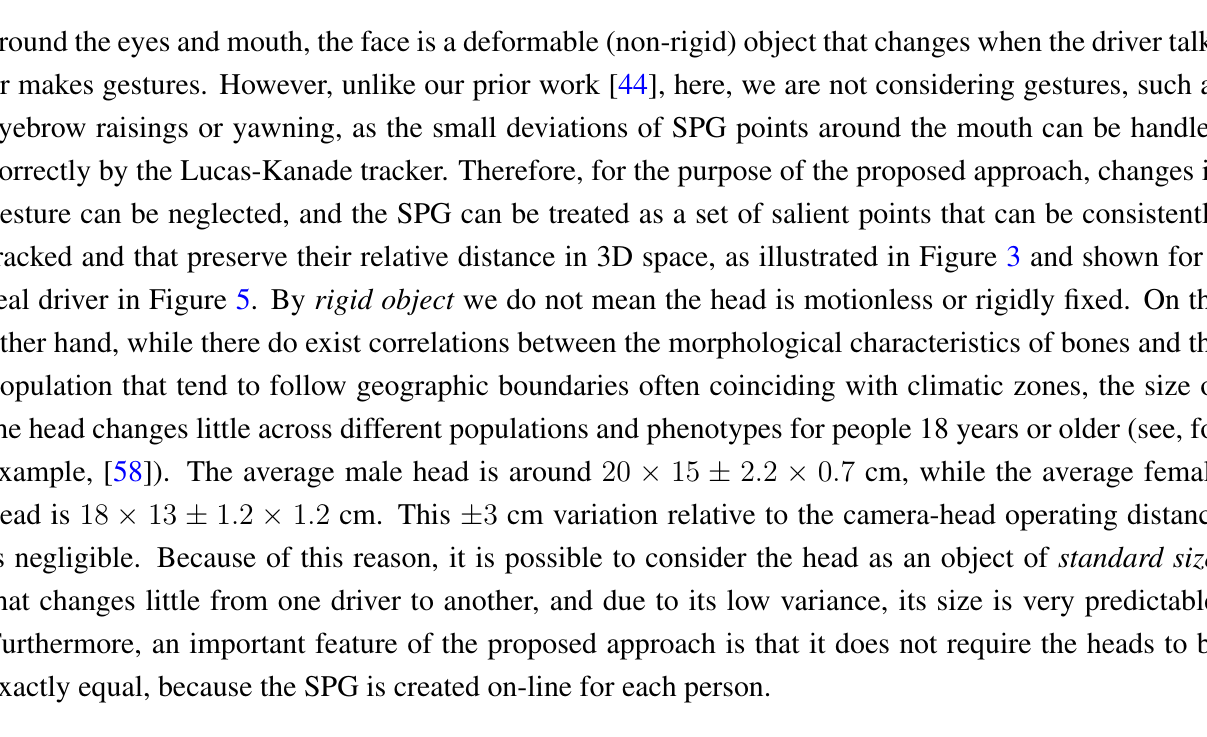
Figure 5. Snapshot of the system